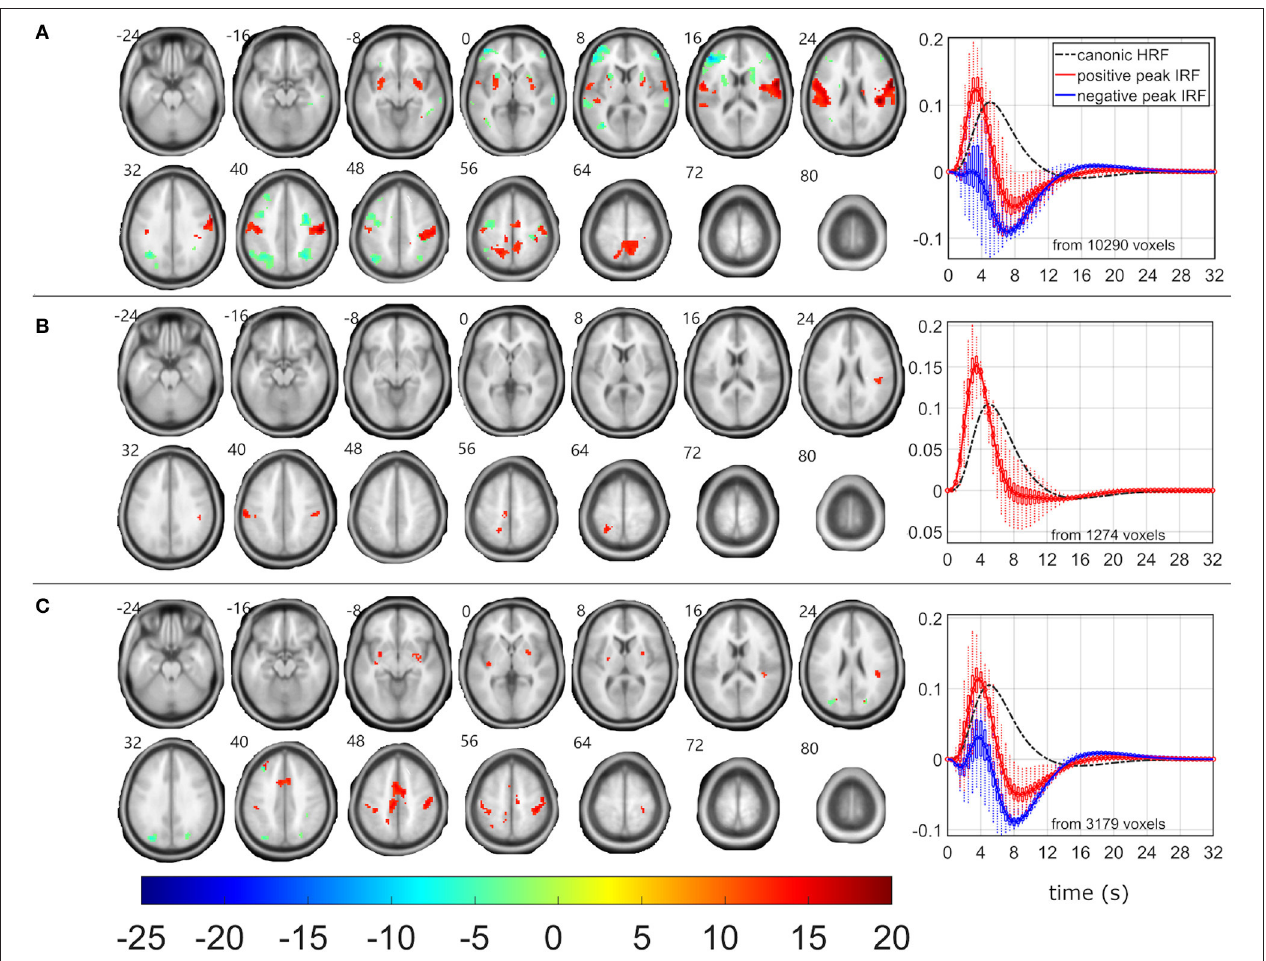
FIGURE 3 | EEG-fMRI F-maps and estimated hemodynamic response functions for all investigated models of the β 1 pattern. The EEG-fMRI F-map colorbar is the same over all models. HRF, hemodynamic response function; IRF, impulse response function. If HRF demonstrated a reduced peak and an amplified trough (i.e., blue color-coded HRFs) the F -values were assigned with a negative sign. The F-maps were threholded with p < 0.0001, i.e., |F| > 8.1. The voxels with |F| > 12.1 met the condition p FWE < 0.05. The red color coded HRFs were derived from voxels with positive signed suprathreshold F -values. All F-maps are shown following the neurological convention, i.e., left hemisphere on the left side of the axial slice. (A) Absolute spectral. (B) Relative spectral. (C) Absolute spatiospectral. (D) Relative